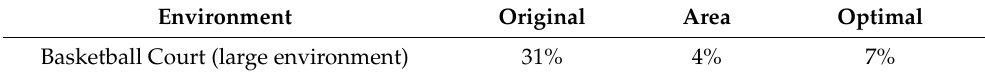
Table 9. Improvement by Fitting Model Compared to Planar Model